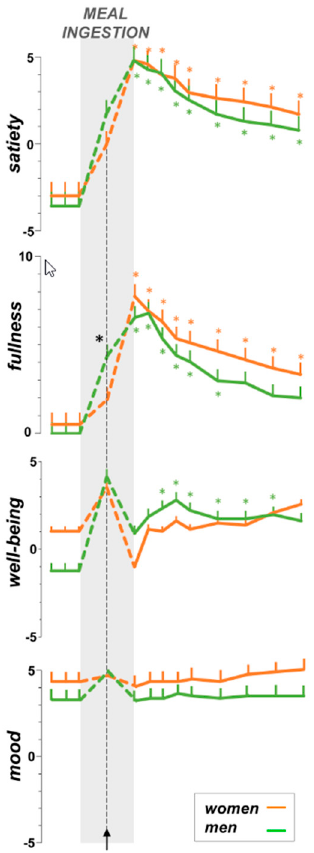
Figure 2. Effect of gender on meal-related sensations. Sensations were scored on 10 cm scales. During meal ingestion, well-being increased up to a peak and then progressively decreased until full satiation. No statistical differences in post-prandial sensations between groups were detected by Analysis of Covariance (ANCOVA), but the post-prandial well-being measured as the area under the curve, was significantly larger in men ( p = 0.047). Temporal responses to meal ingestion analyzed using one-way Analysis of Variance (ANOVA) for repeated measures; asterisks indicate significant differences from pre-meal values by post-hoc comparisons ( p < 0.05 applying the Sidak correction procedure for multiple comparisons).